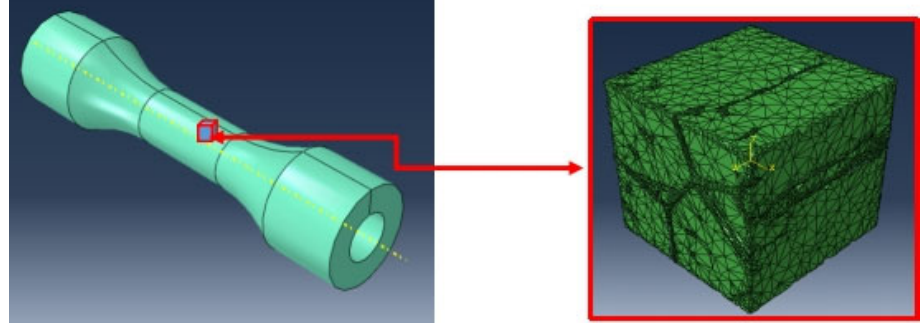
Figure 22. The micro model is embedded into the macro model and a linkage is than